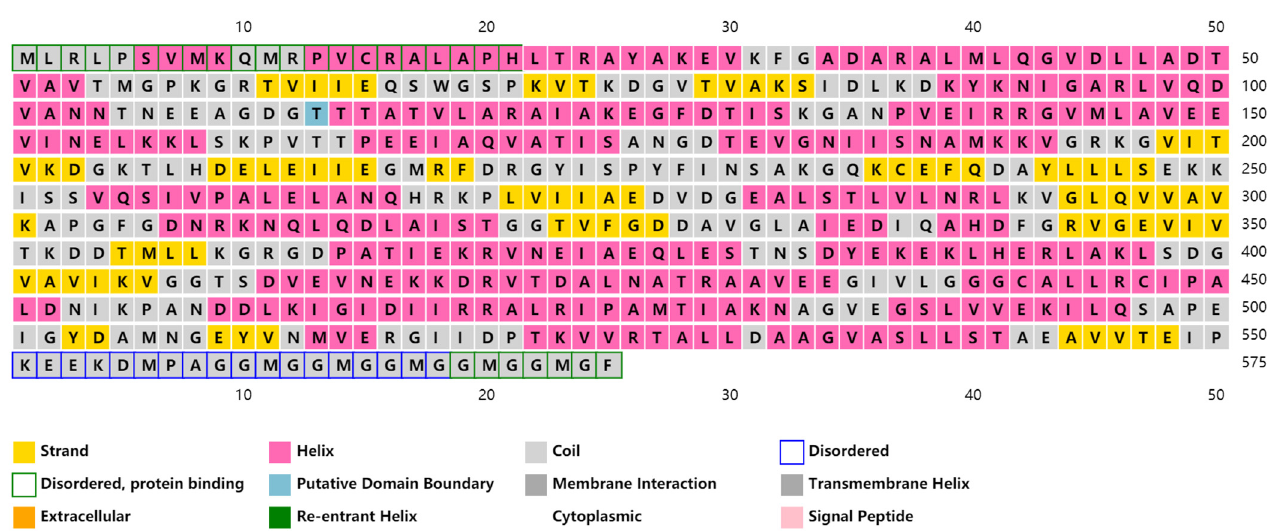
Figure 1. The full-length cDNA nucleotide sequence and corresponding amino acid sequence of Sp HSP60; * indicates a stop codon.